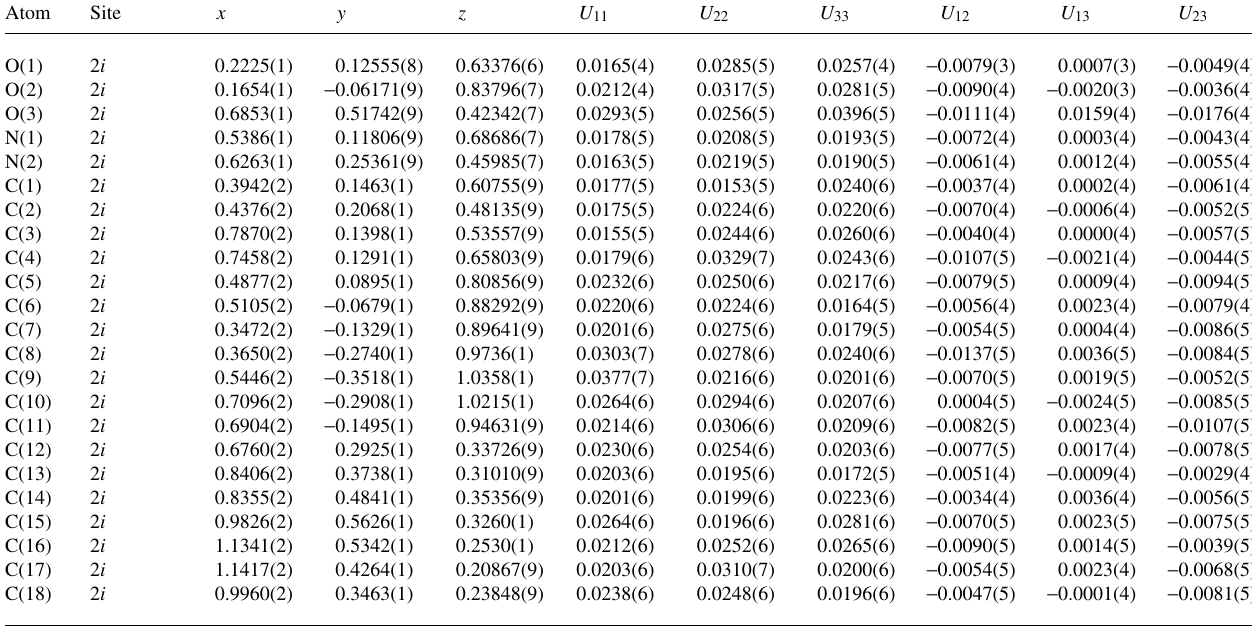
Table 3. Atomic coordinates and displacement parameters (in Å 2 )